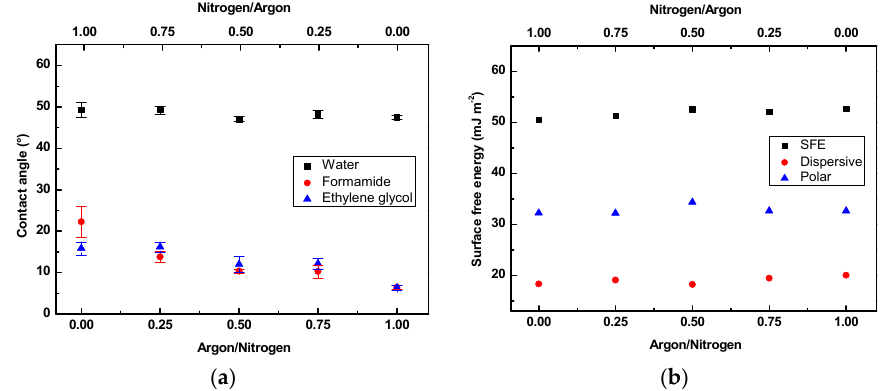
Figure 5. Surface wettability of LDPE treated using nitrogen/oxygen plasma for 120 s as a function of gas concentration ratio: ( a ) contact angle; ( b ) surface free energy (SFE).